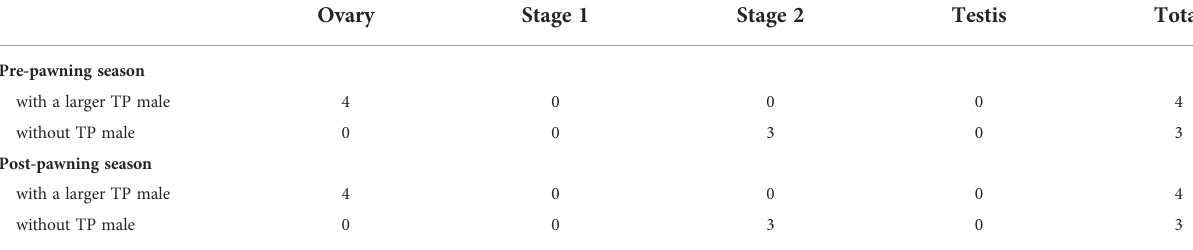
TABLE 1 Gonadal stages of IP fi sh kept with fi ve smaller IP females during the pre-spawning and post-spawning seasons. Ovary Stage 1